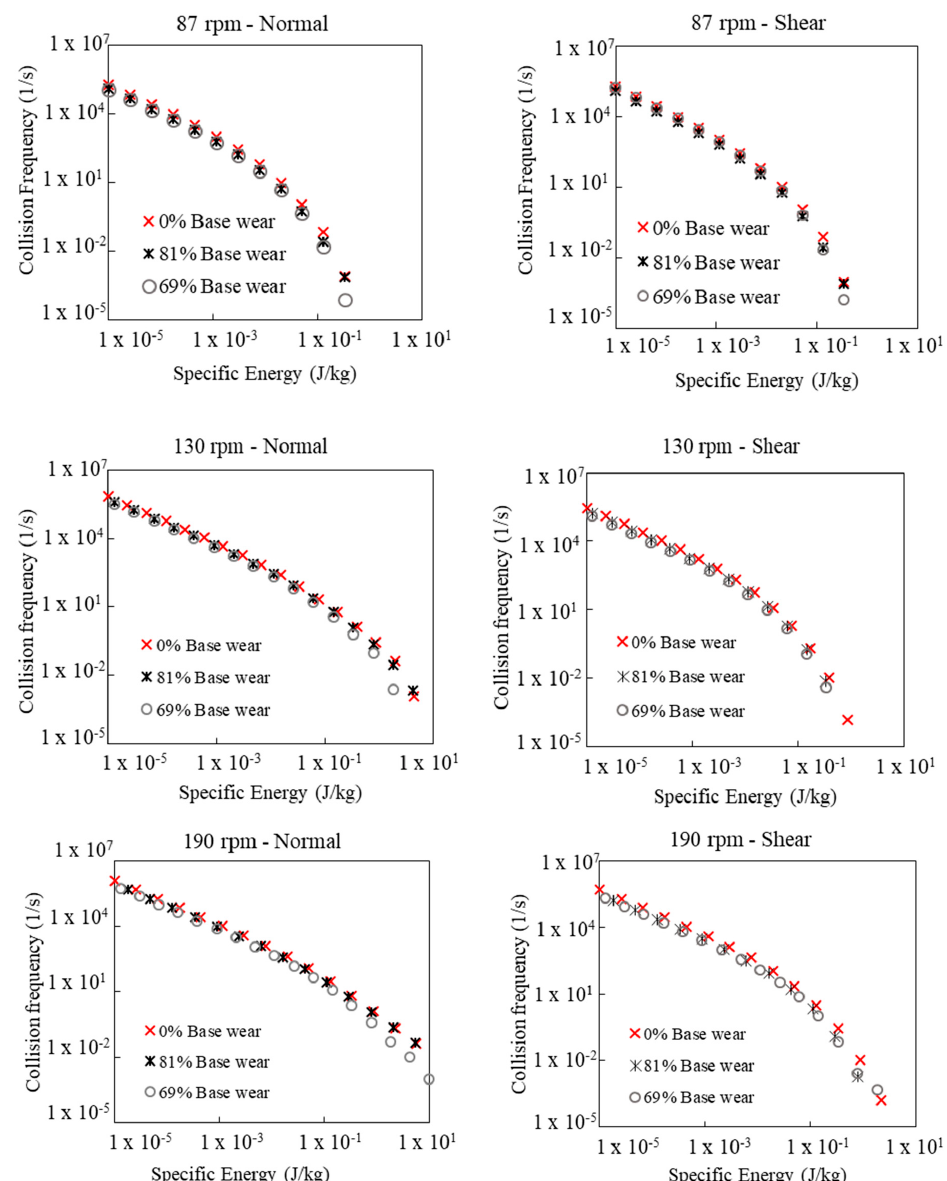
Figure 17. Particle collision spectra at different liner conditions and rotational velocities.